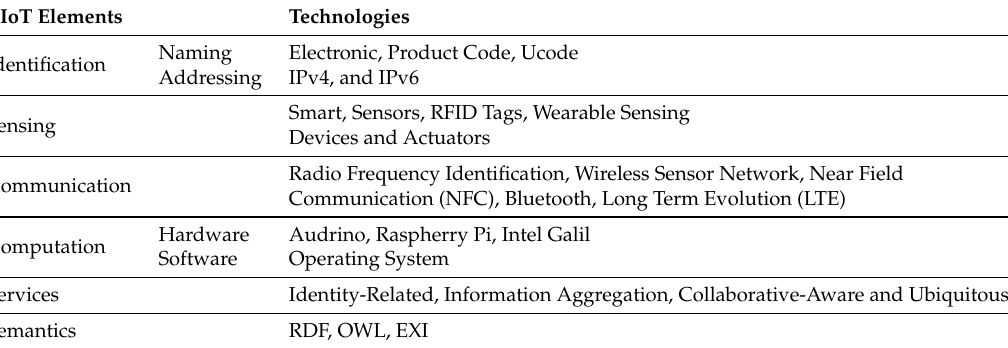
Table 2. The elements and key technologies of